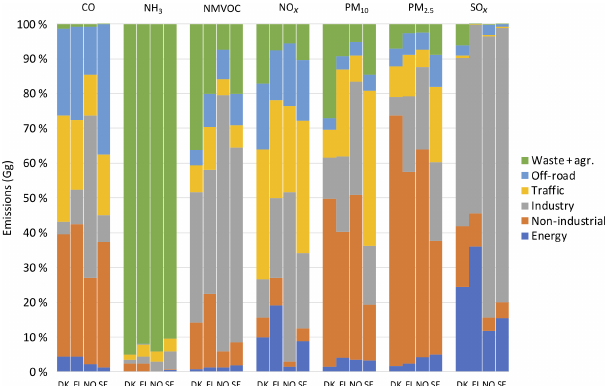
Figure 1. Relative distributions (%) of sectoral emissions of major air pollutants in the Nordic